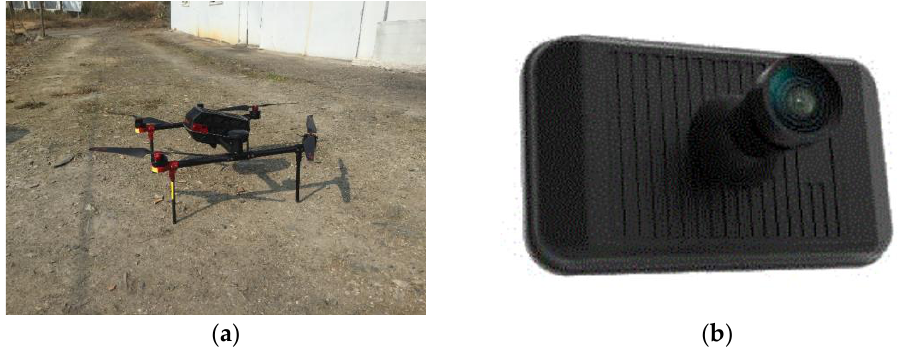
Figure 3. ( a ) The Feima UAV platform; ( b ) the SONY a-6000 digital camara.